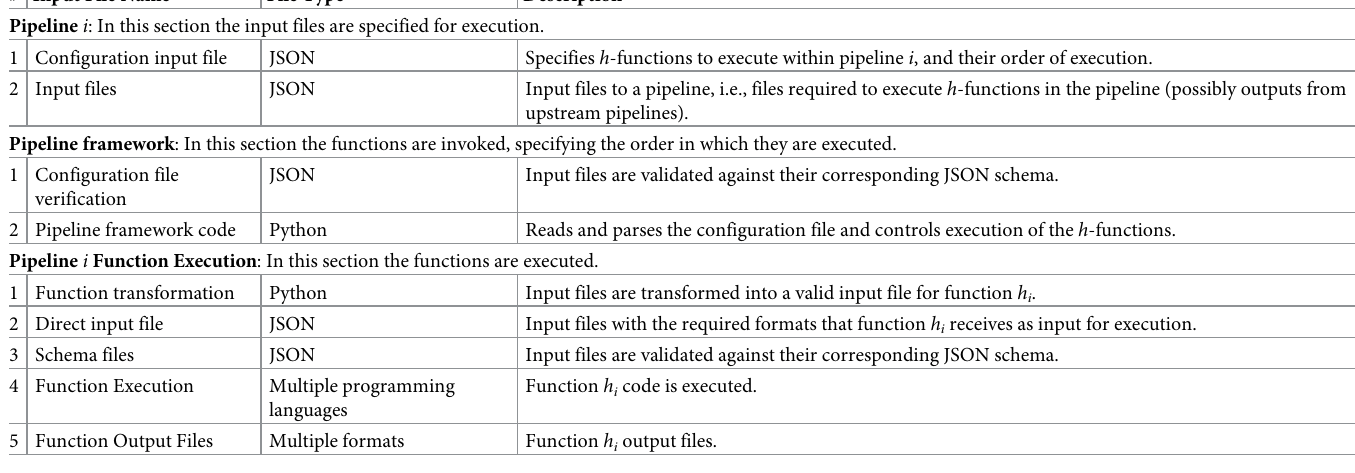
Table 5. Sections and files from the execution of a generic